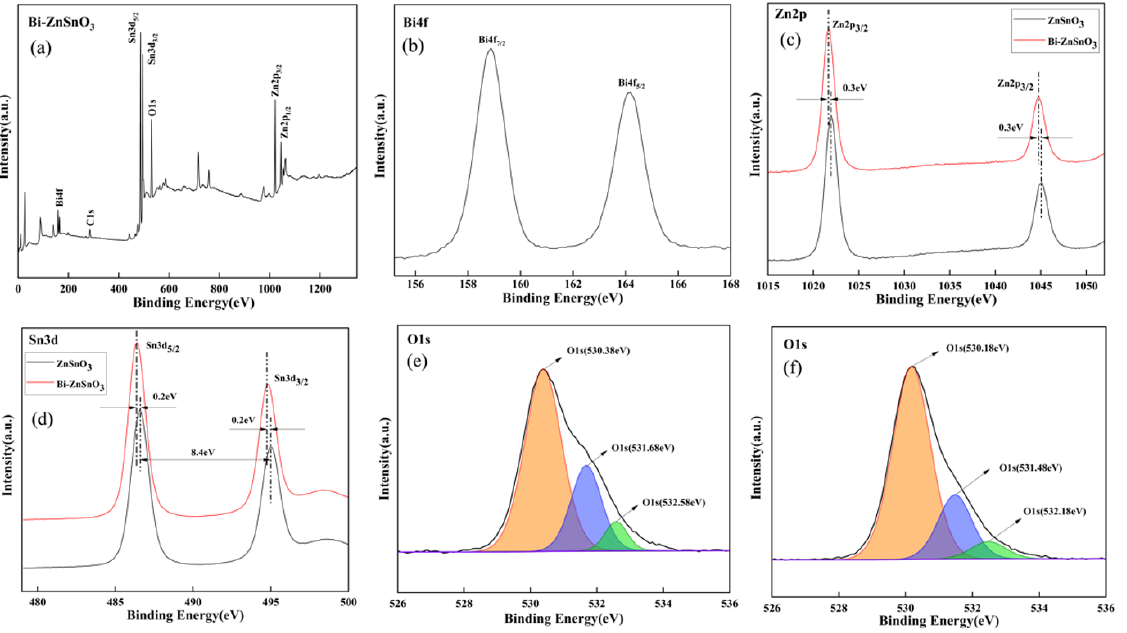
Figure 6. XPS full spectrum of Bi-ZnSnO 3 (4 wt%) composite ( a ), high-resolution spectrum of Bi4f ( b ), high-resolution spectrum of Zn2p ( c ), high-resolution spectrum of Sn3d ( d ), and O1s spectra of ZnSnO 3 and Bi-ZnSnO 3 (4 wt%) composites ( e , f ).